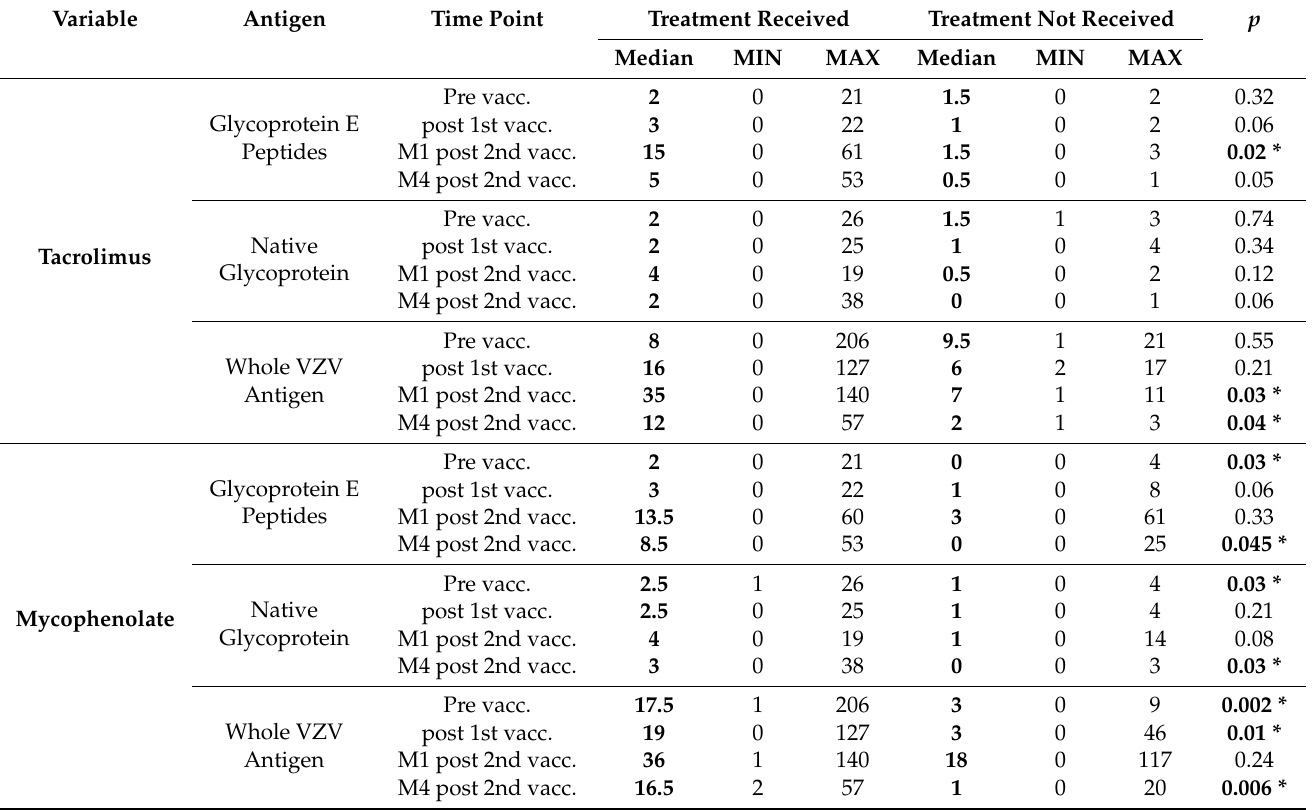
Table 4. Correlation of varicella–zoster virus (VZV)-specific ELISpot responses and immunosuppres- sive treatment in 29 kidney transplant